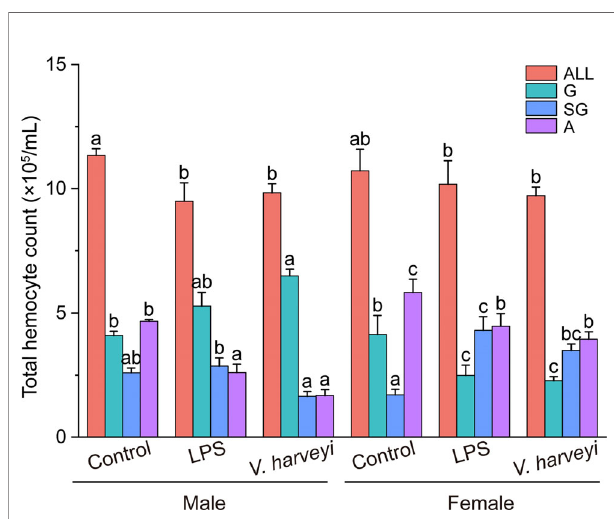
FIGURE 3 | Number of all hemocyte (ALL), granulocytes (G), semi- granulocytes (SG), and agranulocytes (A) of female and male oysters after LPS, V. harveyi , or control stimulation. The means denoted by different letters at each fi xed hemocyte subpopulation are signi fi cantly different among different treatments ( p <